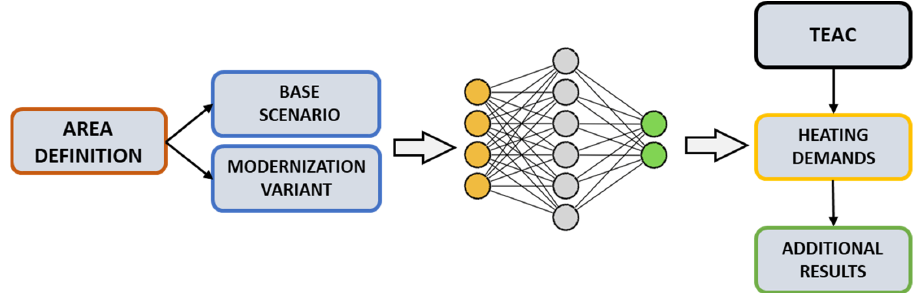
Figure 2. Application of the TEAC software—a procedure schema.